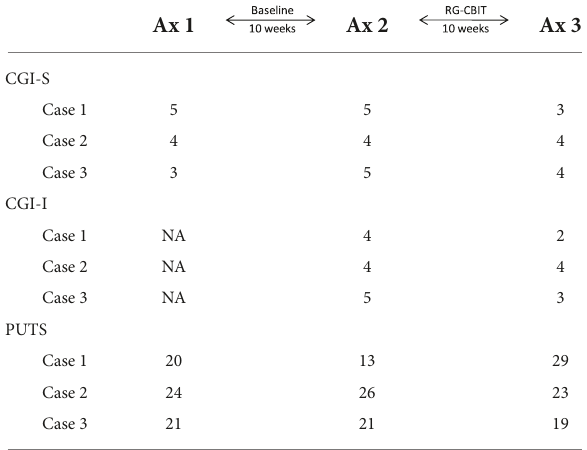
TABLE 3 Clinical outcomes (CGI and